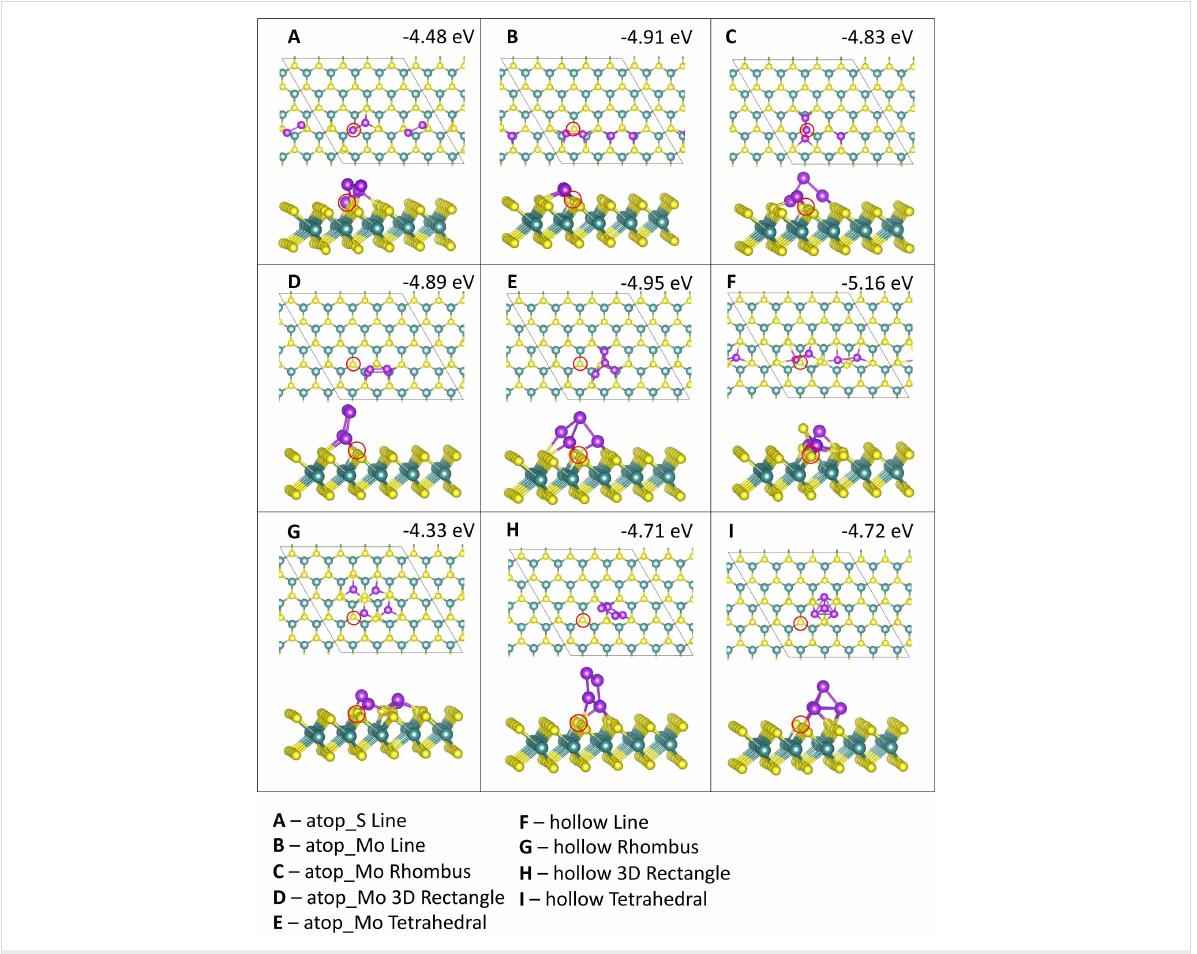
Figure 11: Atomic structure and energies of Ru 4 adsorption modes on defective MoS 2 . The red circle indicates the location of the S